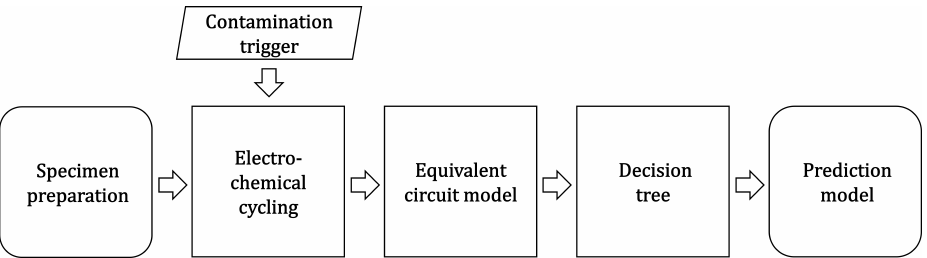
Figure 1. Solving the approach to approve the feasibility of the novel contamination trigger and the ability of a decision tree algorithm to predict a